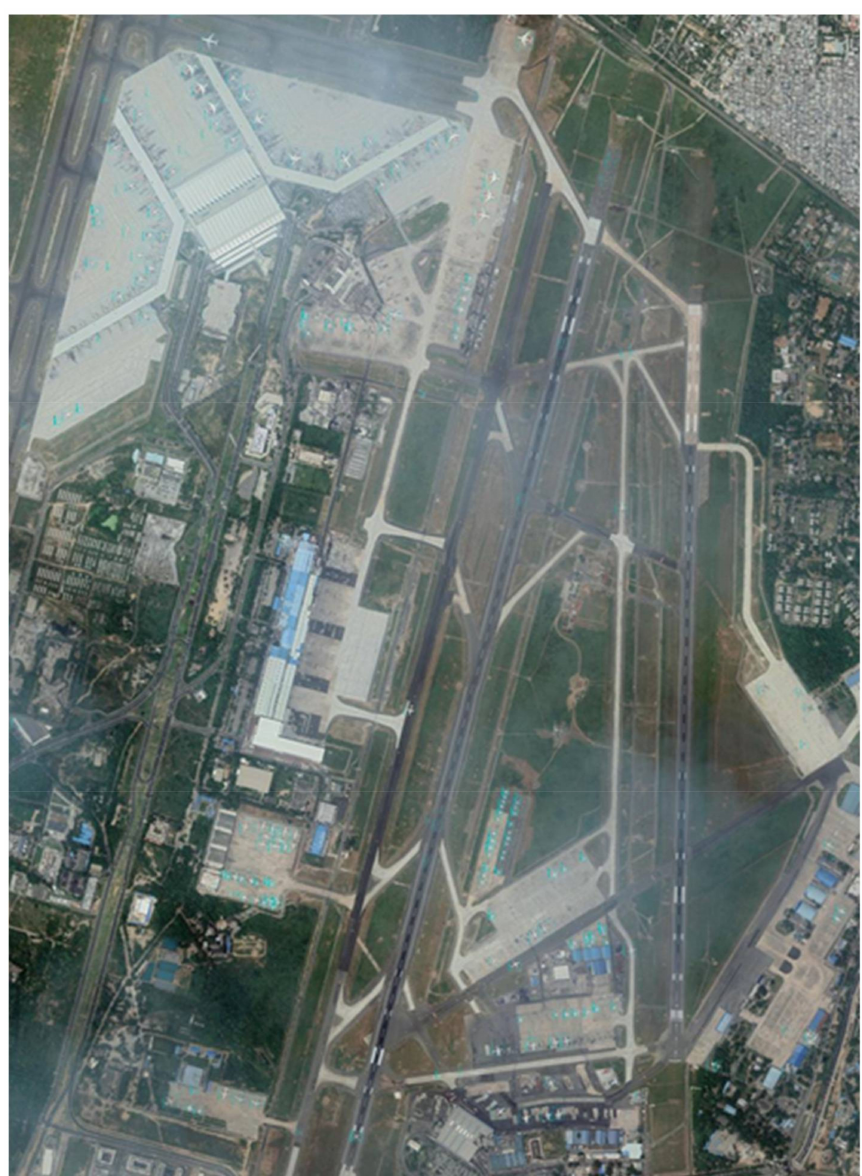
Figure 13. Detection results of SIMRDWN on a 6088 × 8316 resolution satellite